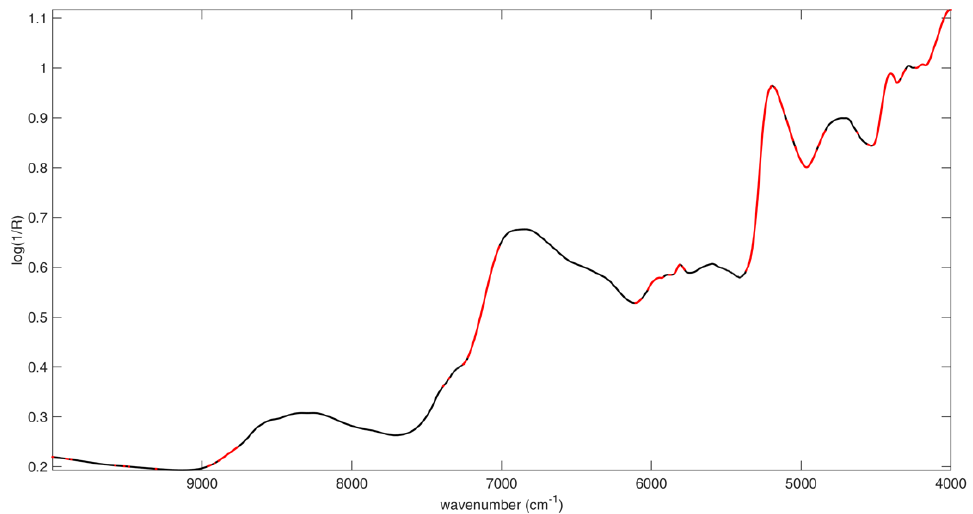
Figure 3. Variable Importance in Projection (VIP) Analysis. Mean spectrum (black line). Variables presenting a VIP index > 1 are highlighted in red.